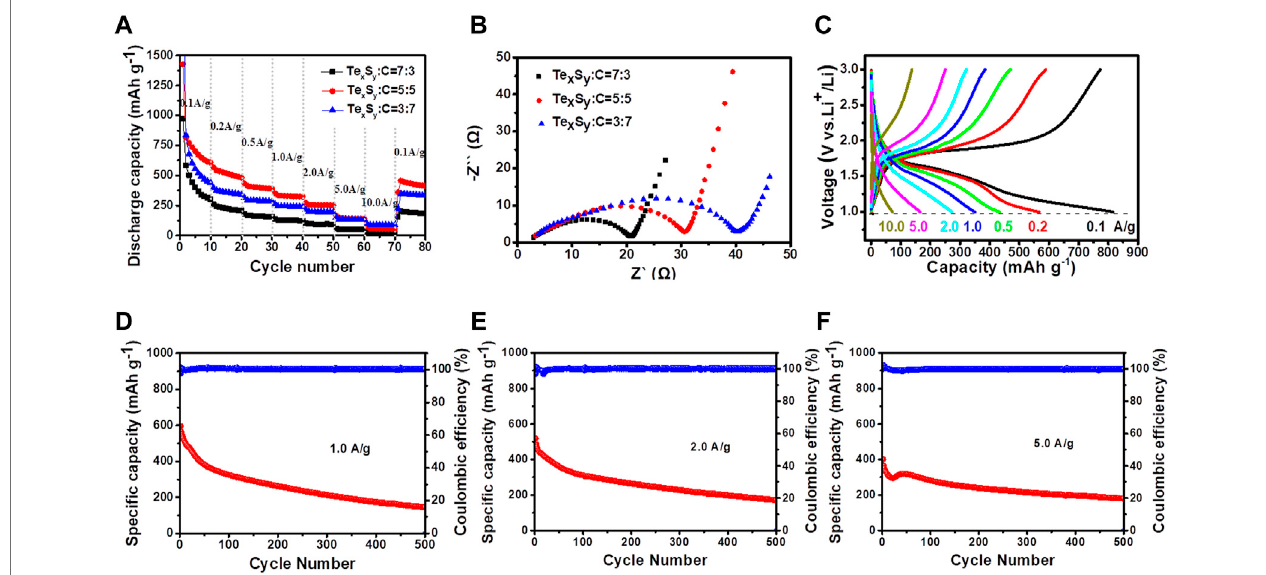
FIGURE4| TheelectrochemicalperformanceofTe x S y (Na 2 S)/MWCNTcomposites: (A) rateperformance, (B) EISmeasurements, (C) charging/dischargingcurves at varied current densities towards the mass ratio of 5:5 Te x S y (Na 2 S)/MWCNT composites, cycling stability and Coulomb ef fi ciency of 5:5 Te x S y (Na 2 S)/MWCNT composites at the current density of (D) 1.0 A g − 1 , (E) 2.0 A g − 1 , (F) 5.0 A g − 1